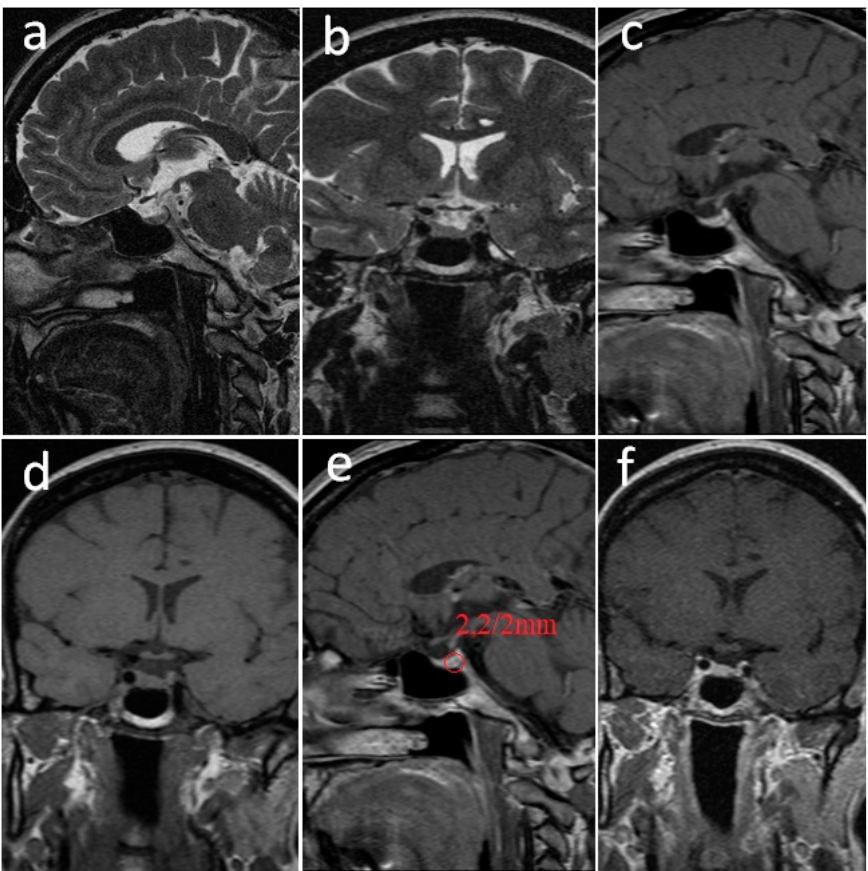
Figure 3. Pituitary MRI performed 6 months after delivery. ( a ). Non-contrast sagittal T2-weighted image. ( b ). Non-contrast coronal T2-weighted image. ( c ). Non-contrast sagittal T-weighted image. ( d ). Non-contrast coronal T1-weighted image. ( e ). Post-contrast sagittal T1-weighted image. ( f ). Post-contrast coronal T1-weighted image. The imaging aspect was the same as that at the beginning of the pregnancy; the pituitary adenoma was located in the left parapituitary in moderate high-signal T2-weighted ( a , b ), low-signal T1-weighted ( c , d ), and non-gadolinium enhanced ( e , f ). The diameter of the pituitary adenoma was 2/2 mm.